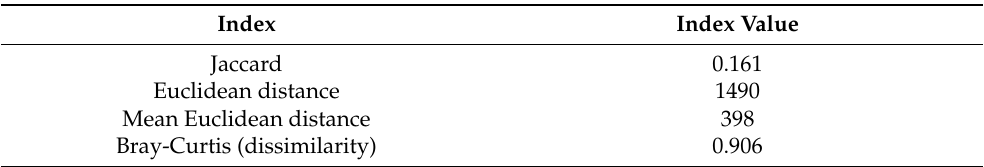
Table 2. Similarity indices of the forests in Chaupisacha and La Reventaz ó n, Pululahua Geobotanical Reserve, Pichincha province, Ecuador. Index Index Value Jaccard 0.161 Euclidean distance 1490 Mean Euclidean distance 398 Bray-Curtis (dissimilarity)